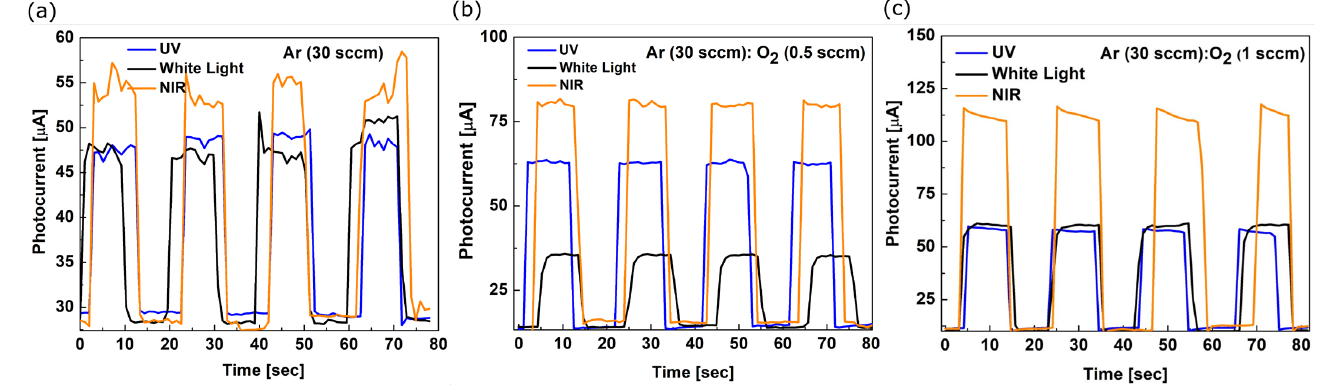
Figure 6. Photogenerated currents, measured by applying pulses of ( a ) UV (360 nm), ( b ) VIS (white light) and ( c ) NIR (860 nm)